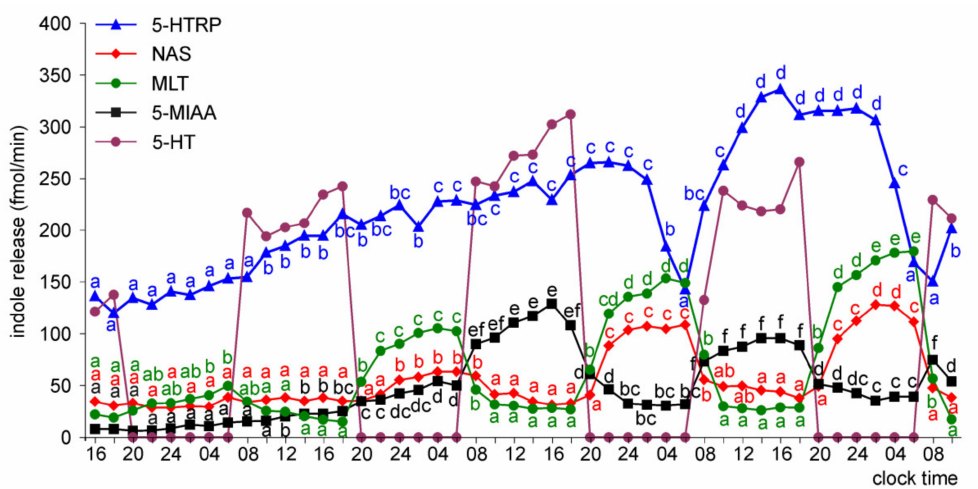
Figure 12. Release of 5-HTRP, NAS, MLT, and 5-MIAA (means, n = 3) from pineal organs of ED 20 embryos incubated under a 12L:12D cycle and treated with NE during photophase. The same letters indicate means, which are not significantly different between time-points.